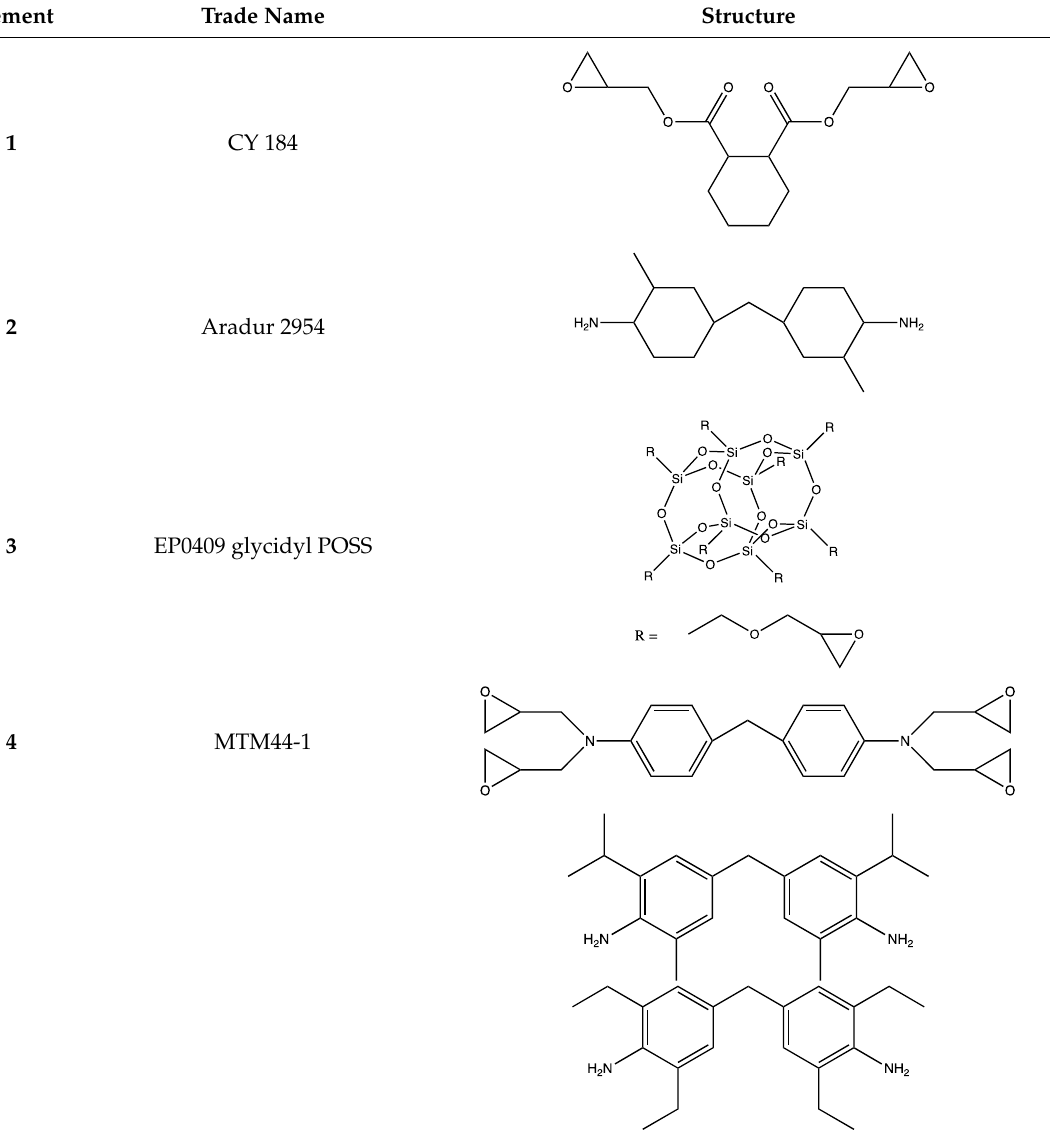
Table 1. The structures of the chemicals used in this work.